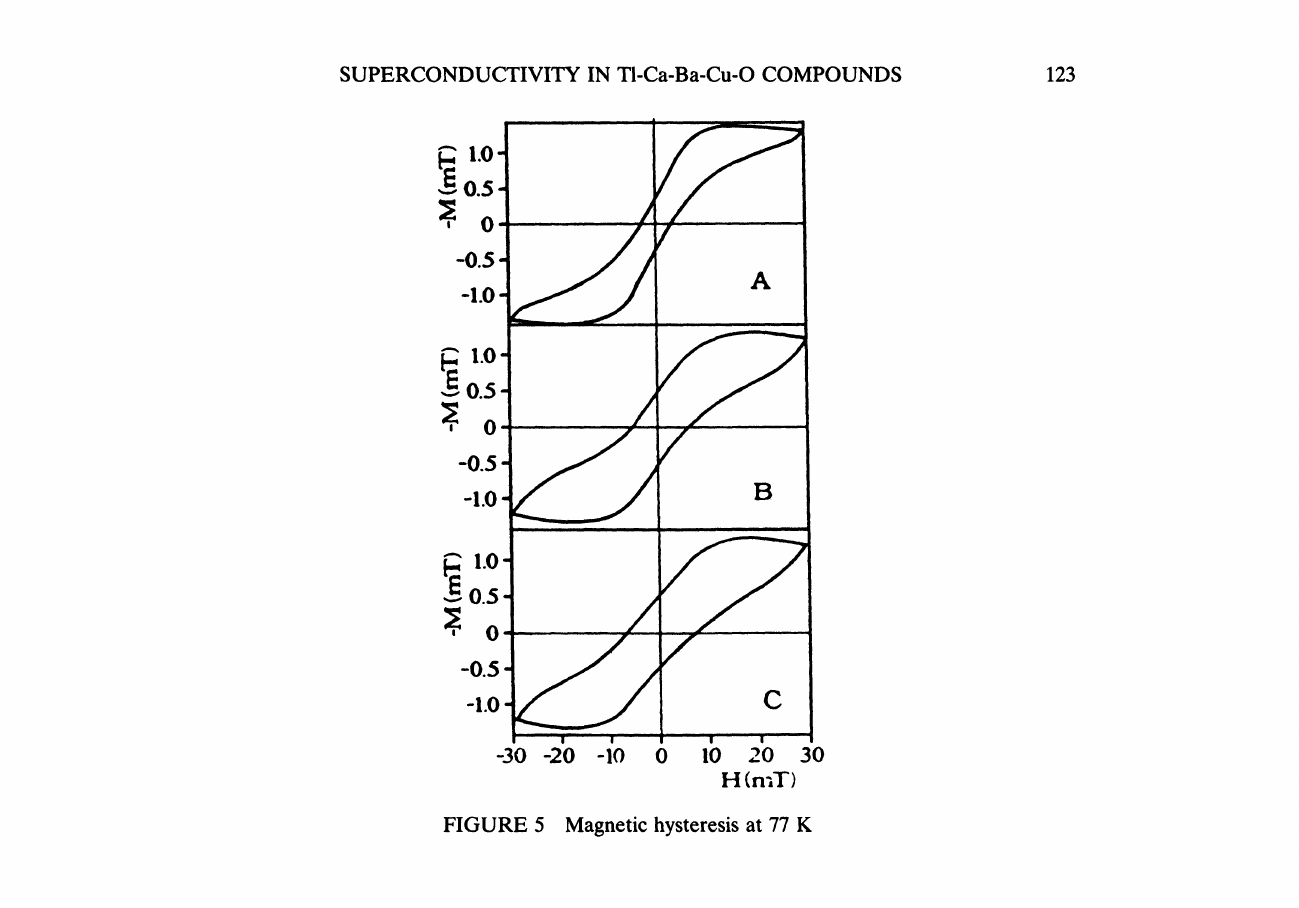
FIGURE 5 Magnetic hysteresis at 77 K